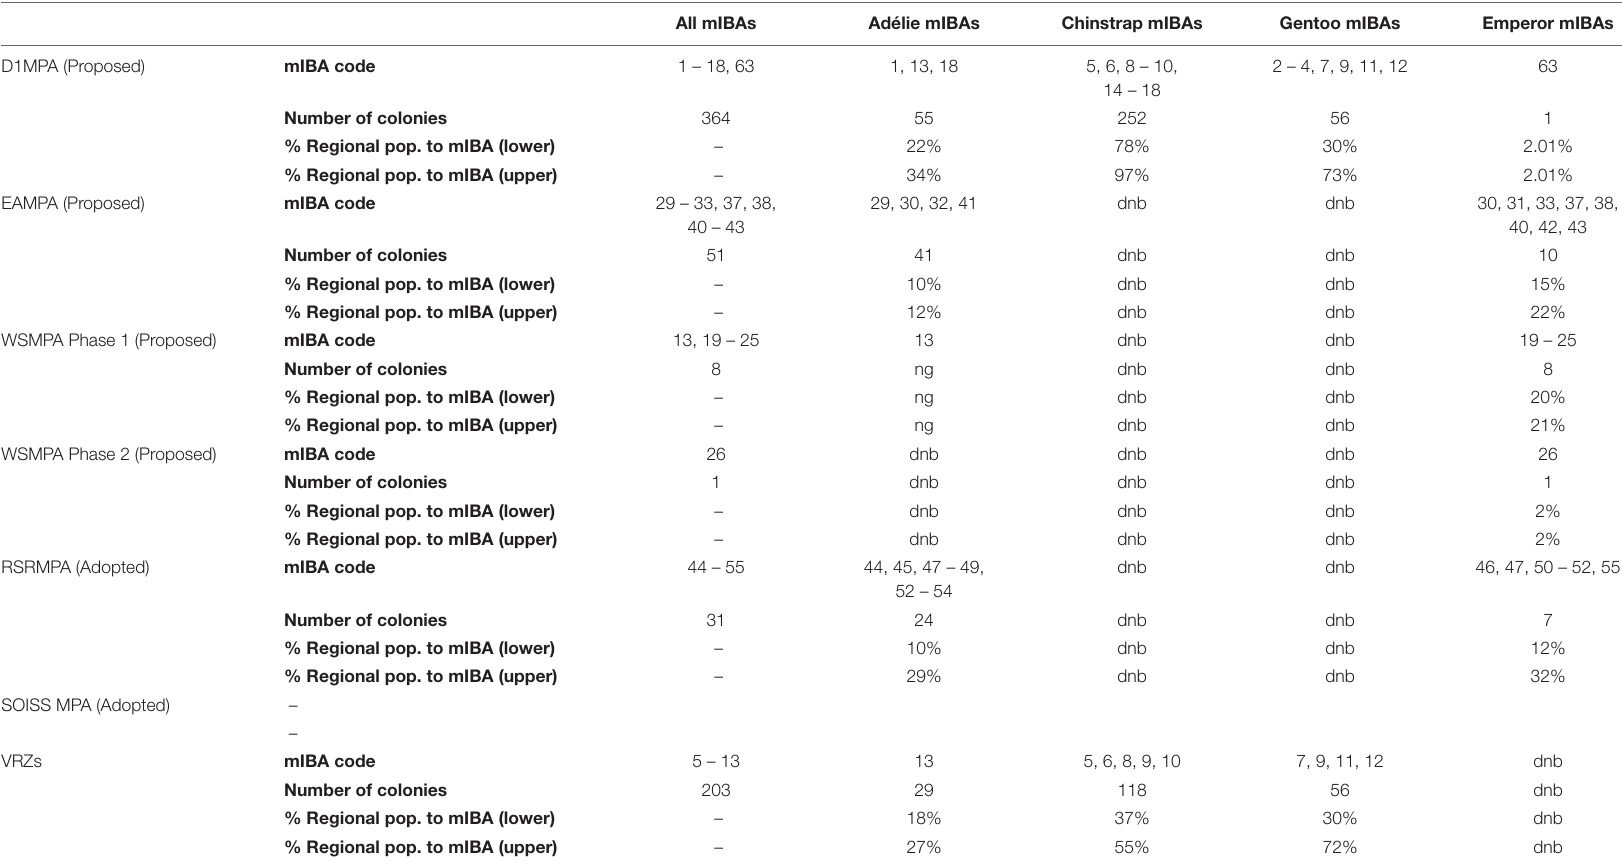
TABLE 5 | Marine IBA overlap with key management areas in waters surrounding Antarctica (see Figure 2 for details), including the number of colonies that contributed to the given marine IBA (based on the density distributions produced for each colony: see section “Materials and